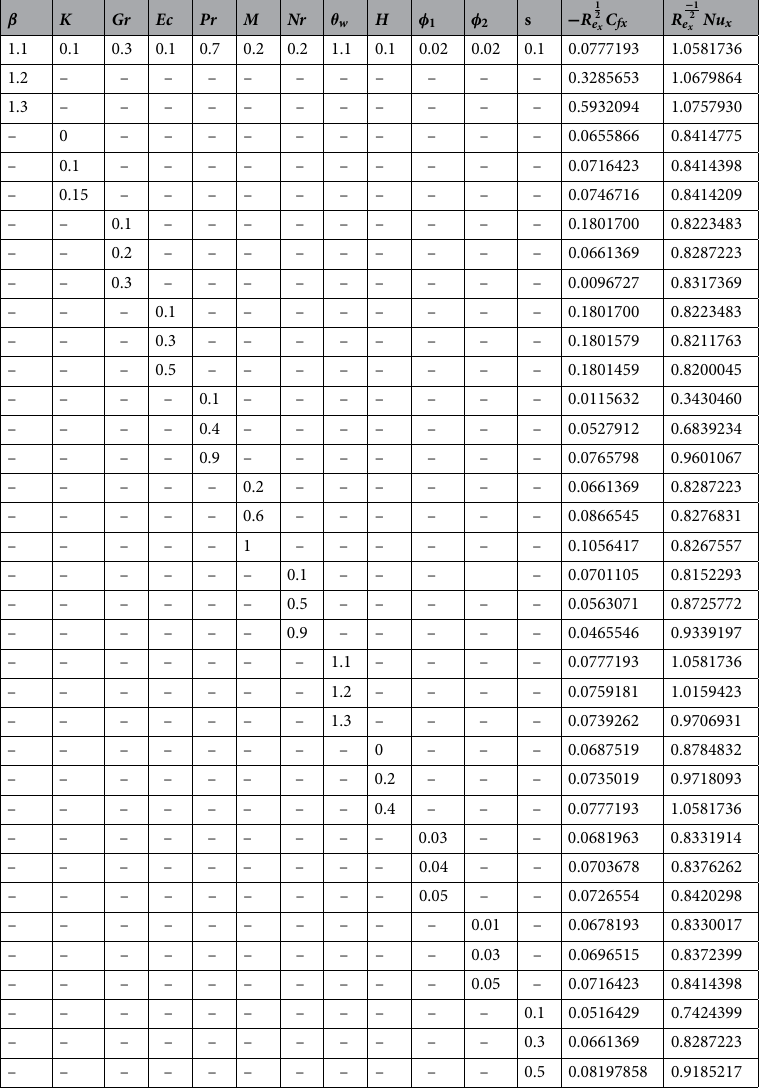
Table 4. Numerical values of skin-friction coefficient ( f ″ (0)) and Nusselt number ( θ ′ (0)) for different values of control